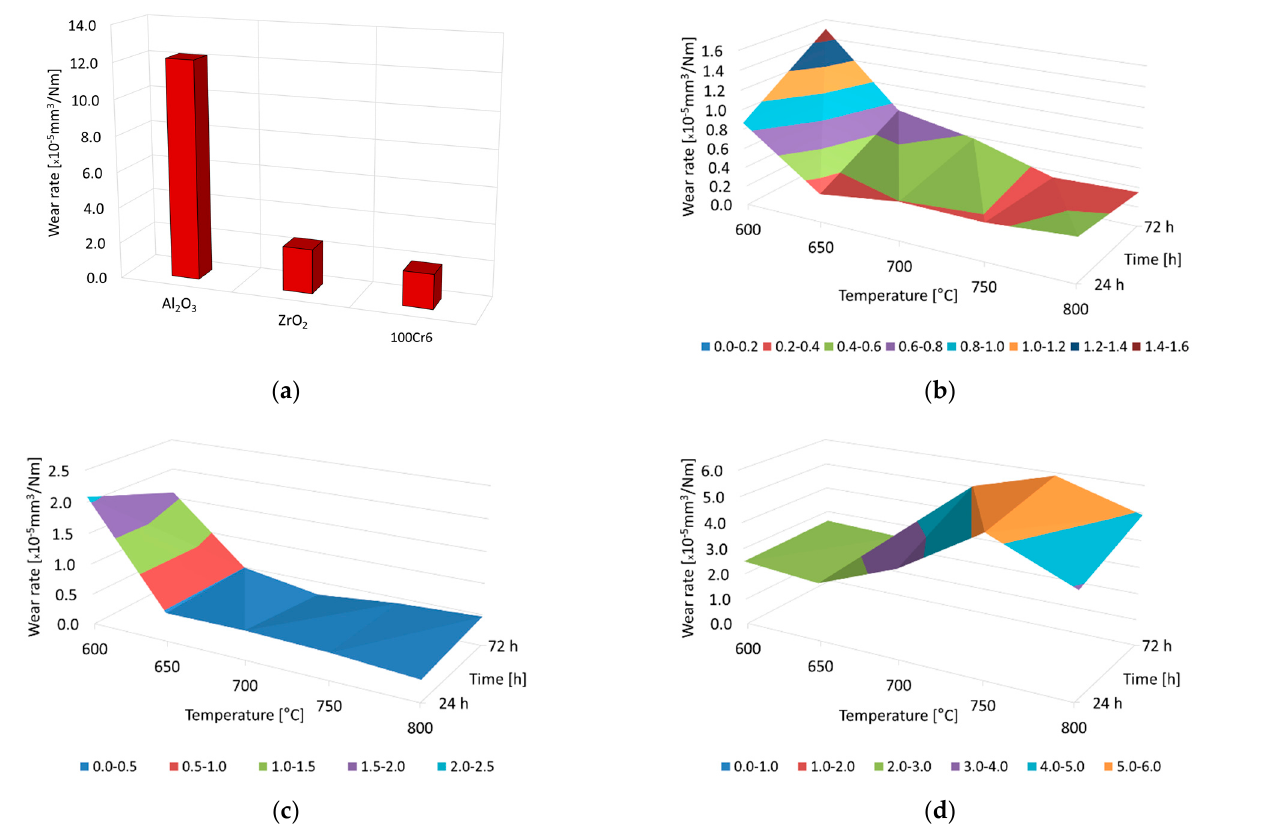
Figure 6. Wear rate of Al 2 O 3 , ZrO 2, and 100Cr6 balls after tribological interaction with the Ti-6Al-7Nb alloy in non-oxidized ( a ) and oxidized conditions ( b —Al 2 O 3 ; c —ZrO 2 ; d —100Cr6) at 600 °C, 650 °C, 700 °C, 750 °C and 800 °C over a period of 24 h and 72 h.